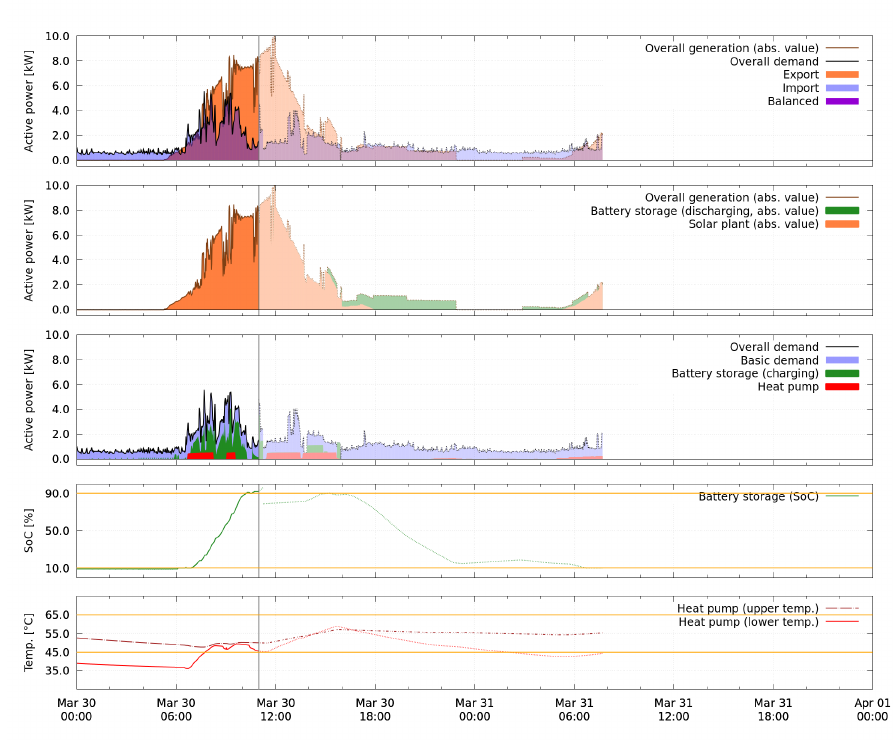
Figure 17. Experimental results from the demonstration site for 30 March: measured history until 11:00 and planned schedules for the following